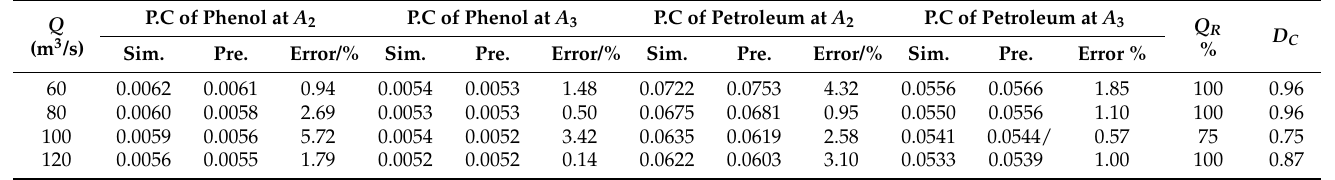
Table 6. The results of the rapid prediction of phenol and petroleum in the L-H section.